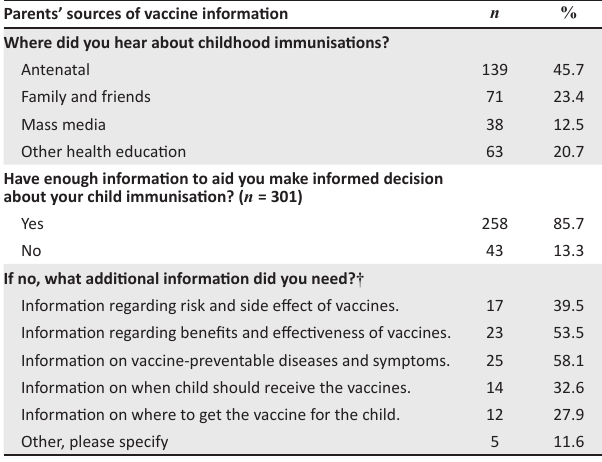
TABLE 2: Parents’ awareness on benefits of child